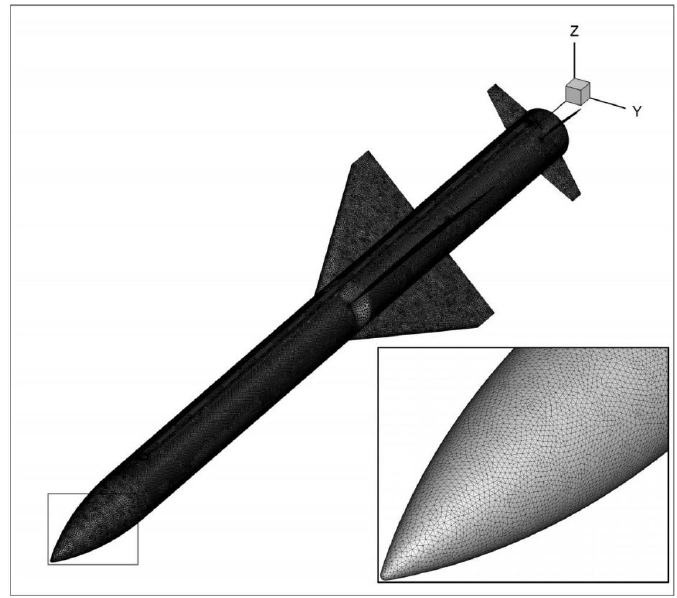
Figure 5. CFD unstructured mesh of the vehicle surface.